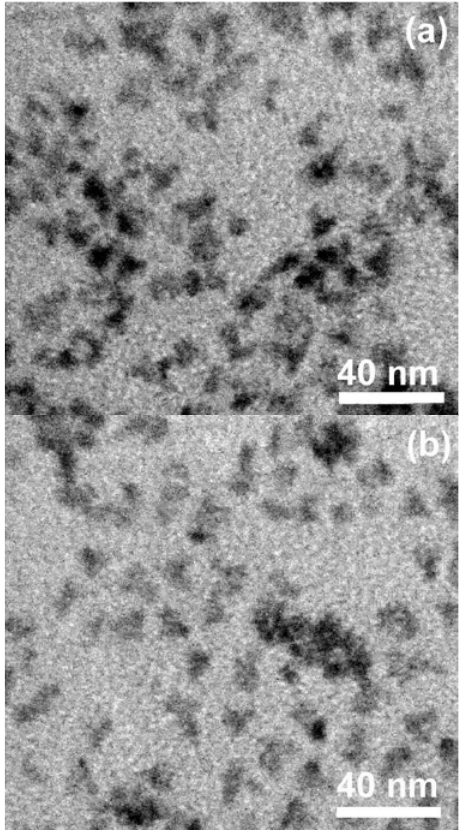
Fig. 3. TEM images of (a) L- and (b)